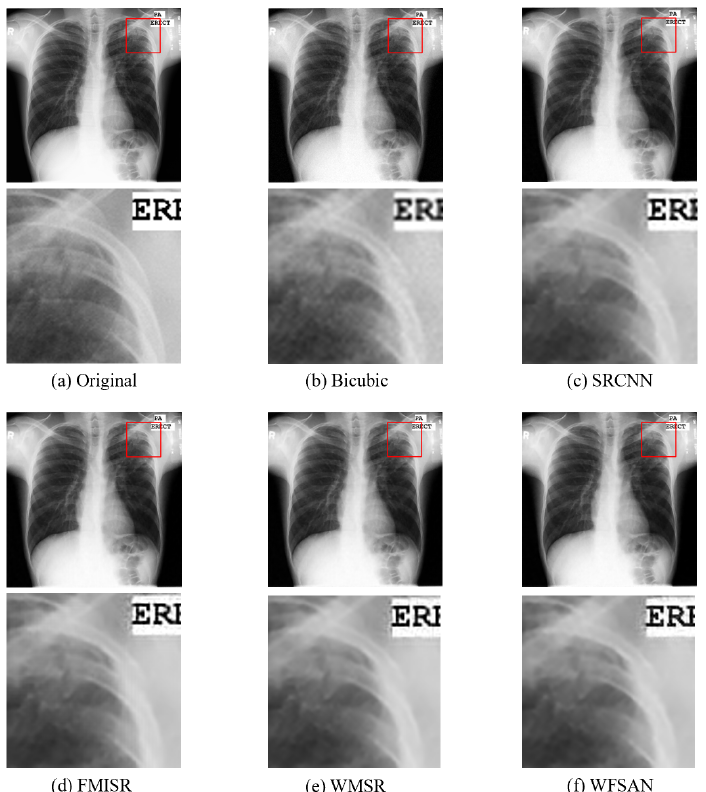
Figure 11. Visual comparison of different models in MontgomerySet normal chest dataset, ( a ) Original(HR) image, ( b ) Bicubic, ( c ) SRCNN, ( d ) FMISR, ( e ) WMSR, ( f ) WFSAN.